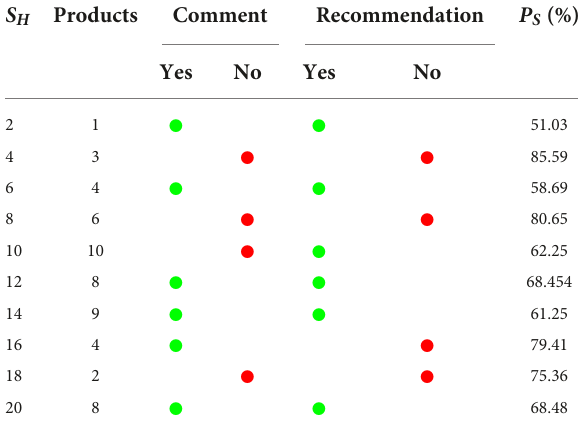
TABLE 1 P s (%) for the varying S H . S H